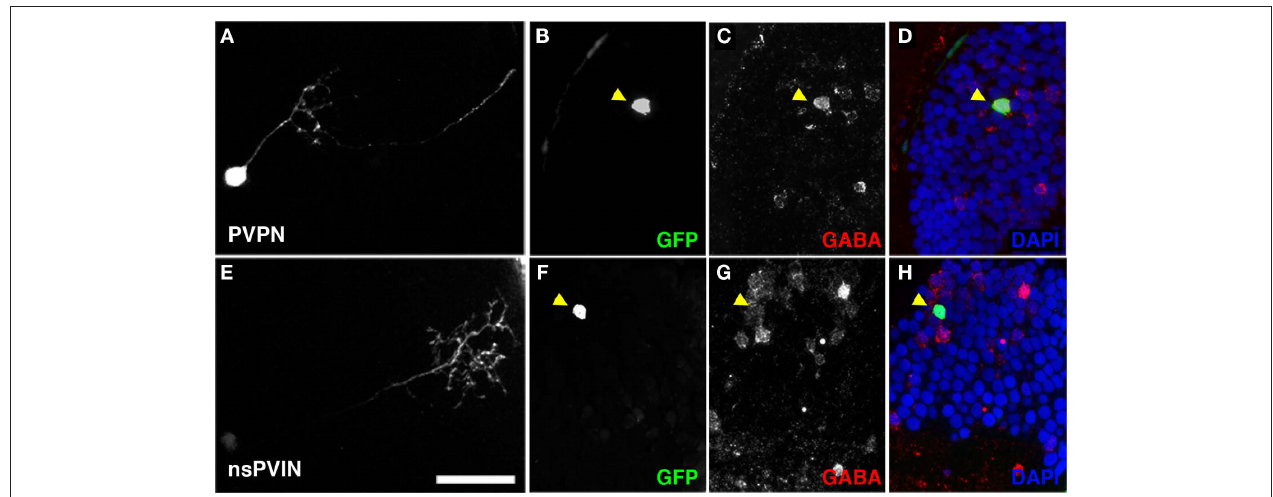
nsPVIN at 5 dpf. (F,G) Single array section containing cell body of neuron in (e) labeled by GFP fluorescence in (F) , anti-GABA immunofluorescence in (G) . (H) Merged image of (F,G) with DAPI nuclear labeling (blue). Note preservation of GFP signal and colocalization of GABA immunoreactivity (arrowheads in D,H ). Scale bar, 20